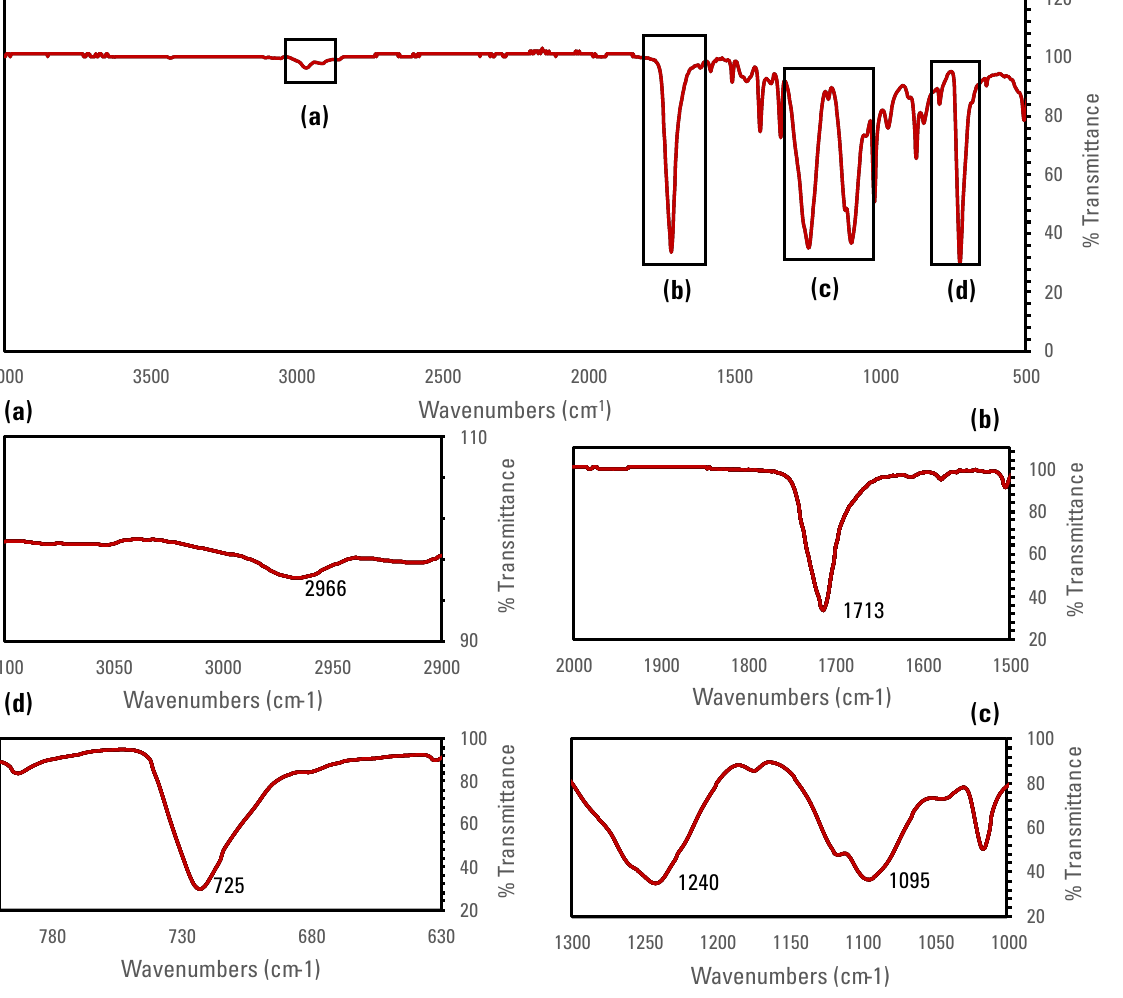
Figure 5. FTIR spectra peak values for rPET, which were detected at the following wavenumbers: ( a ) 2966 cm − 1 for CH bond; ( b ) 1713 cm − 1 for CO bond; ( c ) 1240, 1095 cm − 1 for O bond; ( d ) 25 cm − 1 for CO 2 bond. Table 2. Specific functional groups ’ FTIR absorption wavenumbers.